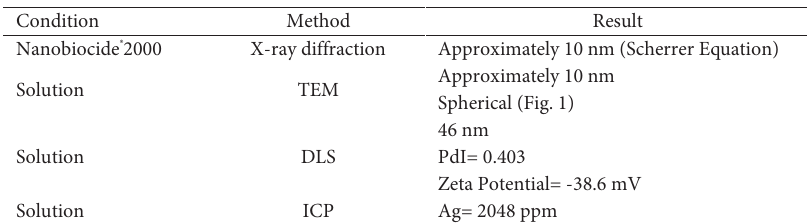
Table 1. Ag-NPs Table 1. Ag-NPs characterization